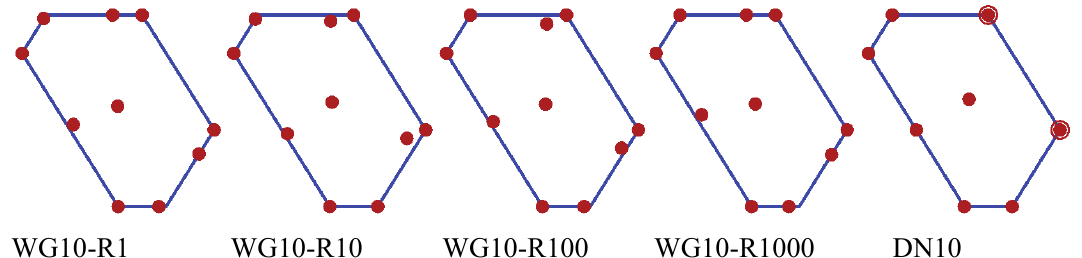
Fig. 1. The competing designs for the poultry experiment. and represent 1 and 2 replicates of that design point,